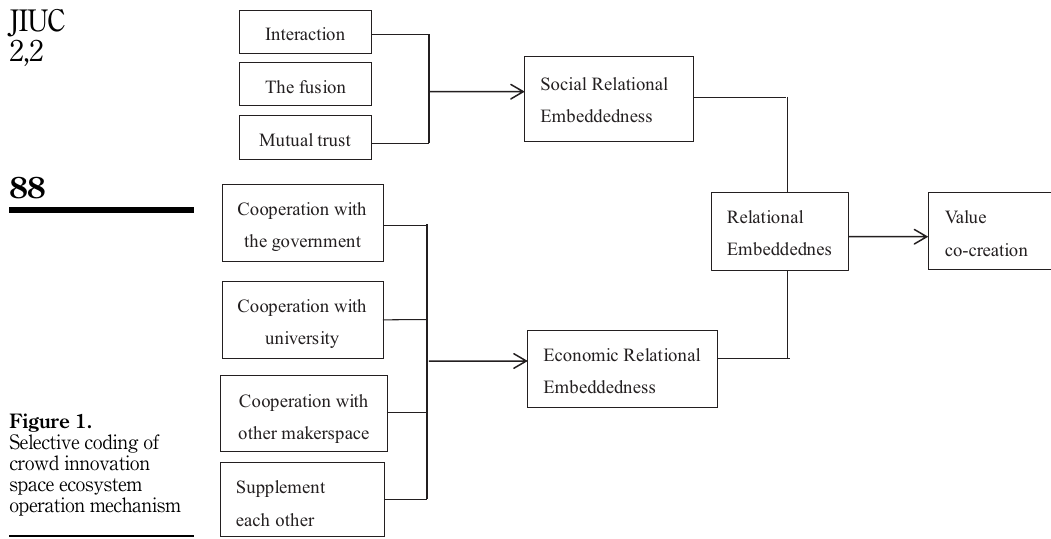
Figure 1. Selective coding of crowd innovation space ecosystem operation